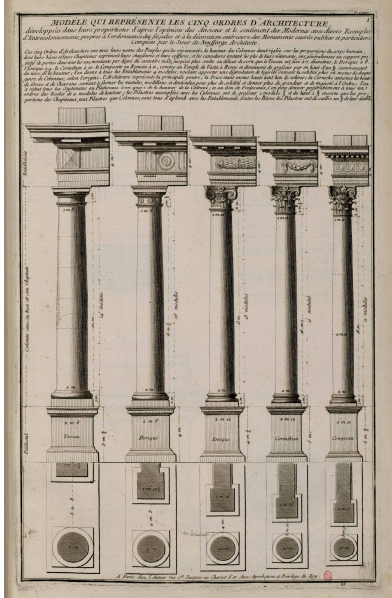
Figure 3. Table of the comparison of the orders. Vol. 1, 3° cahier, tav. 1, p.